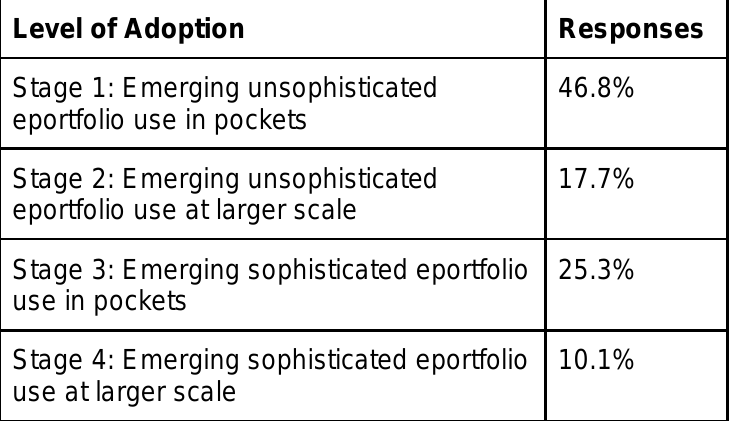
Table 3. Institutional levels of eportfolio adoption adapted from Eynon &